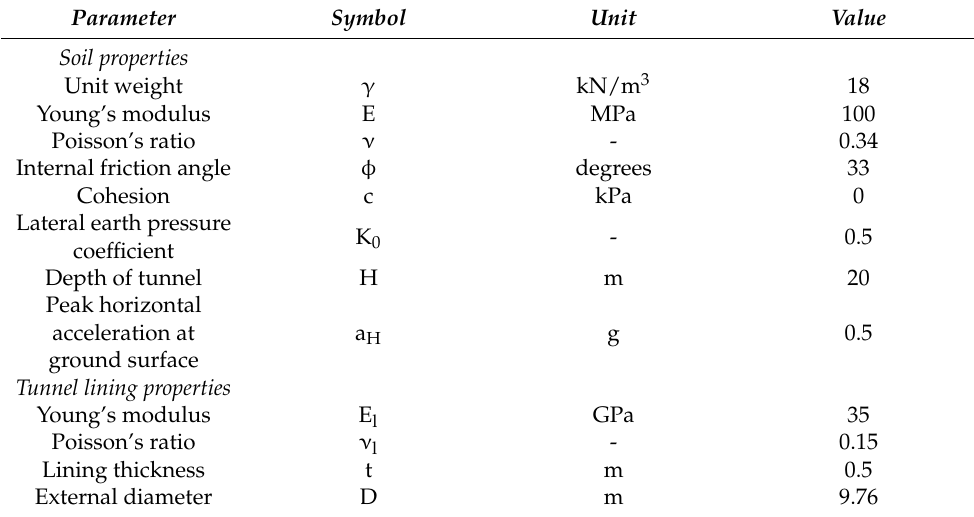
Table 1. Input parameters for the reference case study.